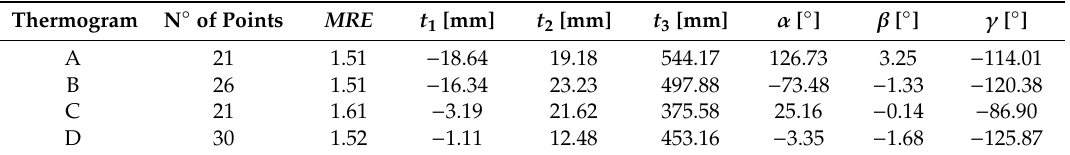
Table 1. Extrinsic parameters for four di ff erent thermograms, in the case of the method based on the manual selection of the homologous points (first method).